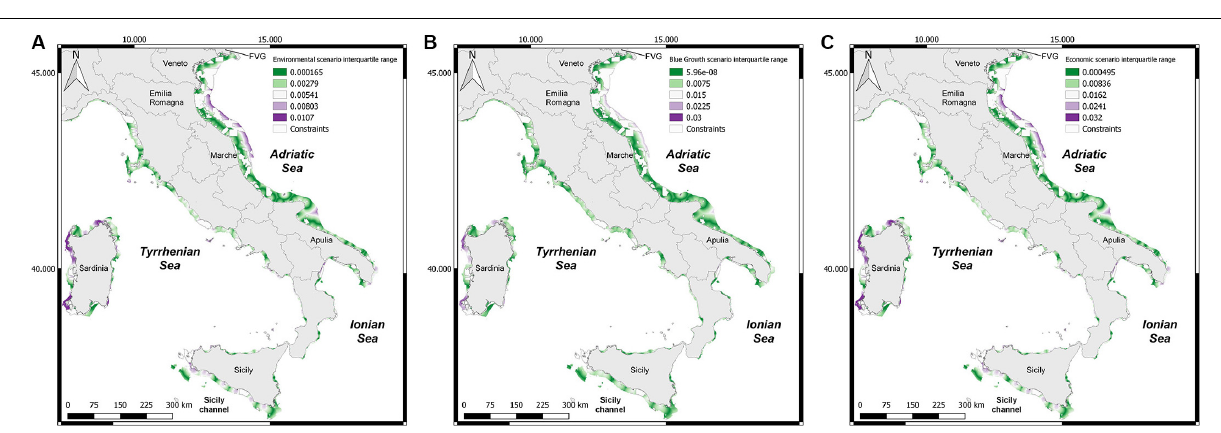
FIGURE 4 | Spatial multi-criteria evaluation uncertainty (interquartile range/median) for the 3 scenarios considering the current sea uses and protected areas: (A) Environmental. (B) Blue Growth. (C)